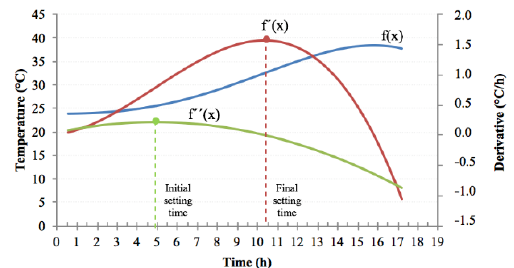
Figure 6. Scheme representing the determination of the initial and final setting times by the derivatives method.